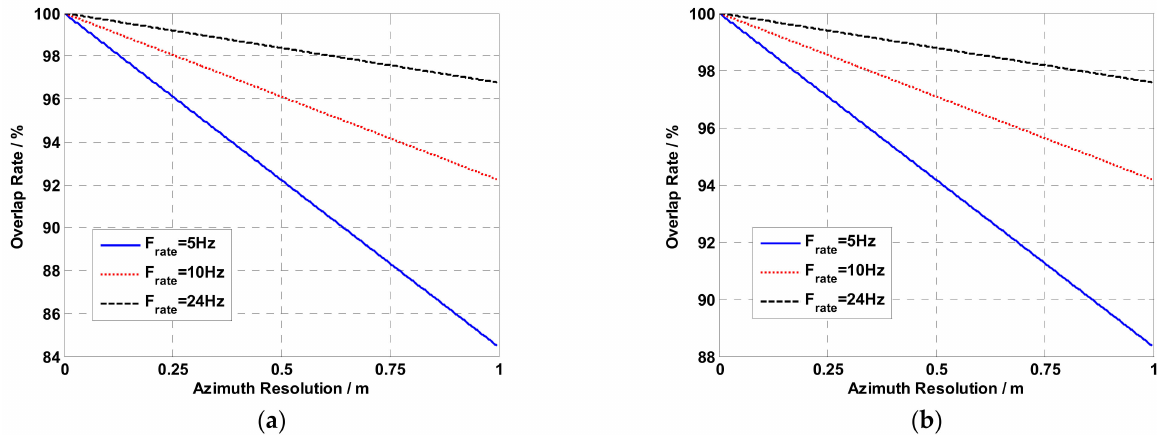
Figure 5. Overlap rate results of typical airborne ViSAR system with velocity of 100 m/s and scene center slant range of 30 km. ( a ) squint angle equals to 0 degrees. ( b ) squint angle equals to 30 degrees.